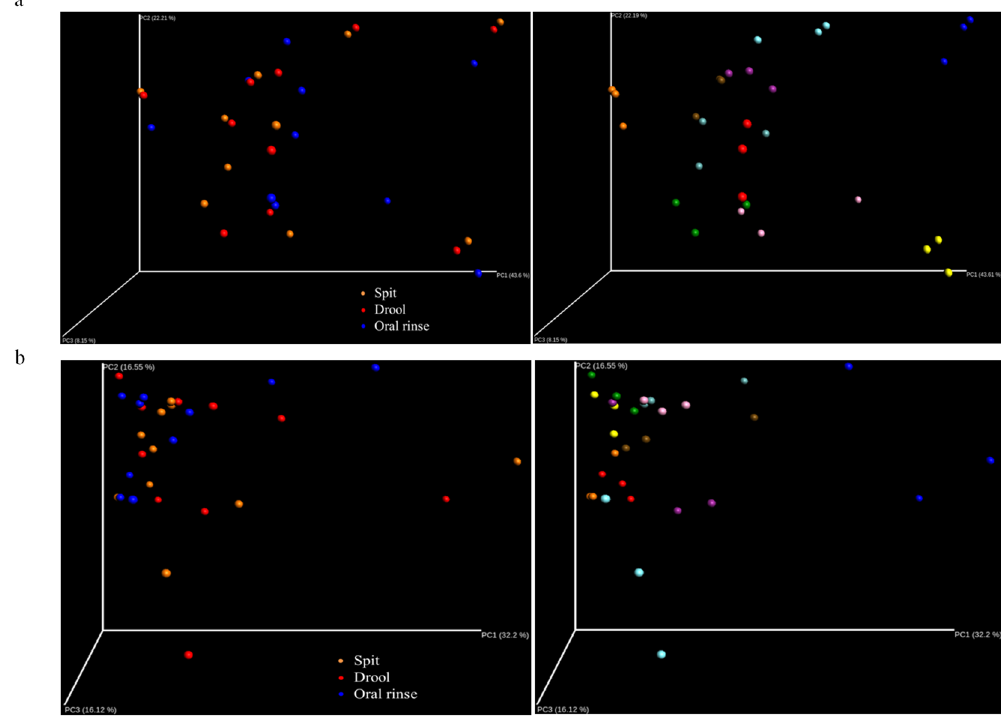
Figure 6. Beta-diversity of salivary microbiome. Weighted ( a ) and unweighted ( b ) PCoA plot for spit, drool and oral rinse samples with respective adjacent plots emphasizing on the subjects in different representing colours.